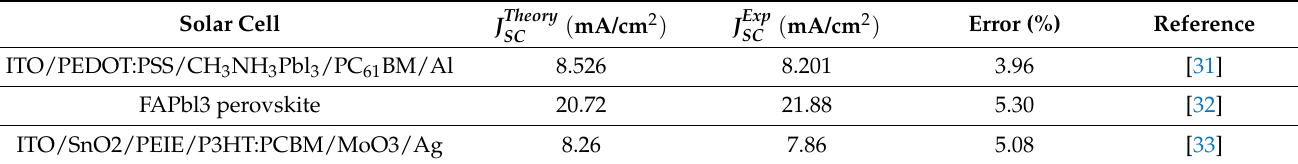
Table 2. Comparison of theoretical and experimental J SC